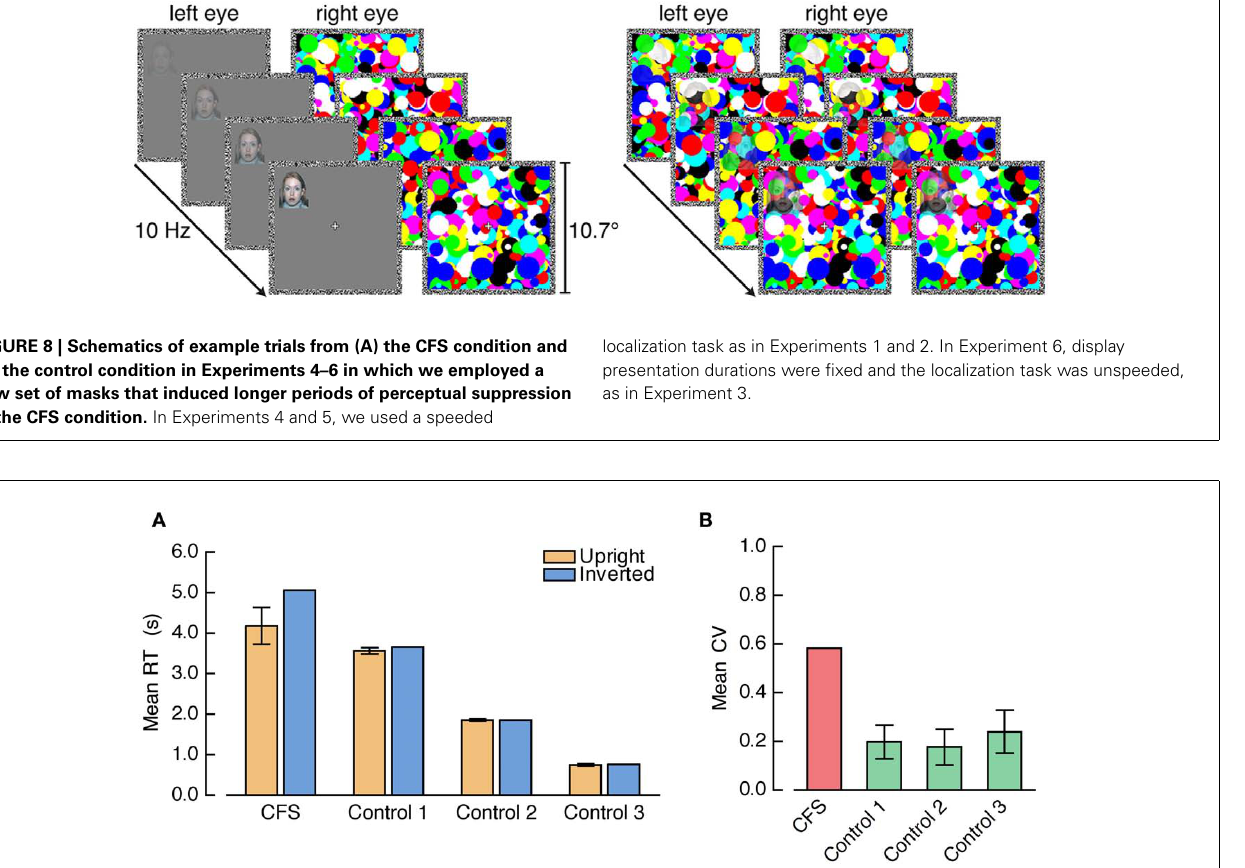
FIGURE 9 | (A) Mean RTs and (B) mean CVs from Experiment 4. “Control 1” refers to the 8.5-s ramp, “Control 2” refers to the 2.5-s ramp, and “Control 3” refers to the no-ramp control condition.